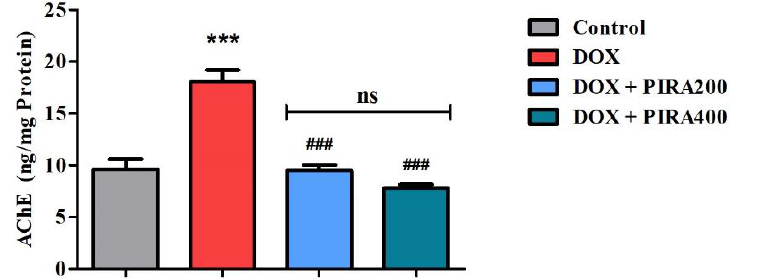
Figure 4. Effect of piracetam (PIRA) on acetylcholinesterase (AChE) levels in brain homogenates of the doxorubicin (DOX)-induced rat model. The results are expressed by mean ± SEM ( n = 7). A one-way ANOVA [ F (3,24) = 31.87, p < 0.001] was conducted, followed by a Tukey – Kramer multiple comparisons test. *** p < 0.001 as compared to the control group; ns — not significant as compared to the control group; ### p < 0.001 as compared to the DOX-induced group.